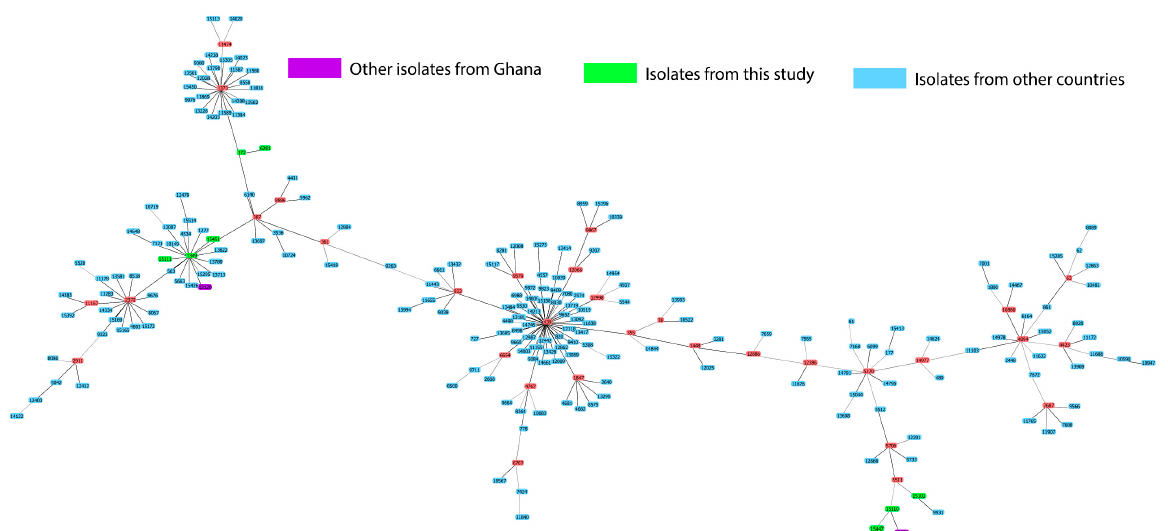
Figure 4. Genetic relatedness of serotype 23B isolates from this study compared with serotype 23B isolates from the PubMLST database. PubMLST database (accessed on 29 September 2020). Green color represents STs reported from this study, blue color, STs from other countries, purple color, STs of other serotype 23B strains from Ghana.